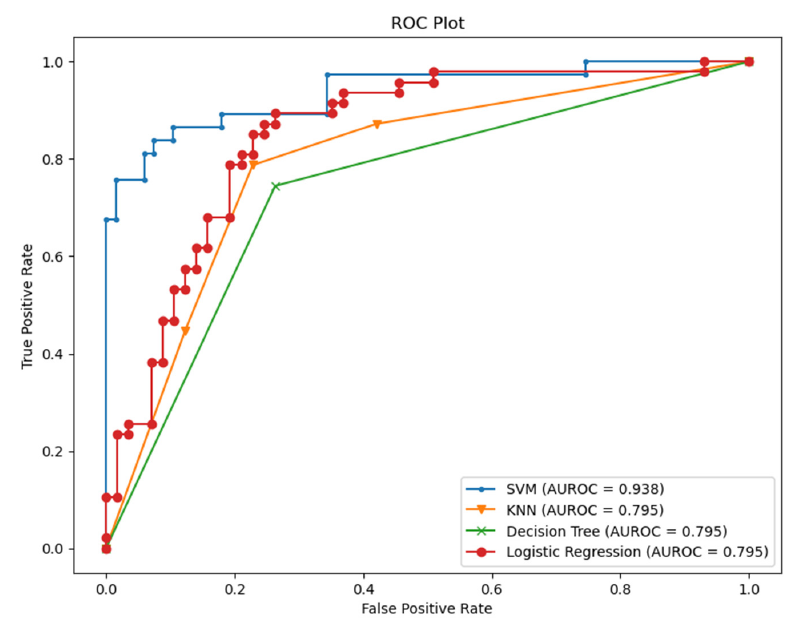
Figure 9. AUC-ROC for the classifiers (HRV + Feeling features).